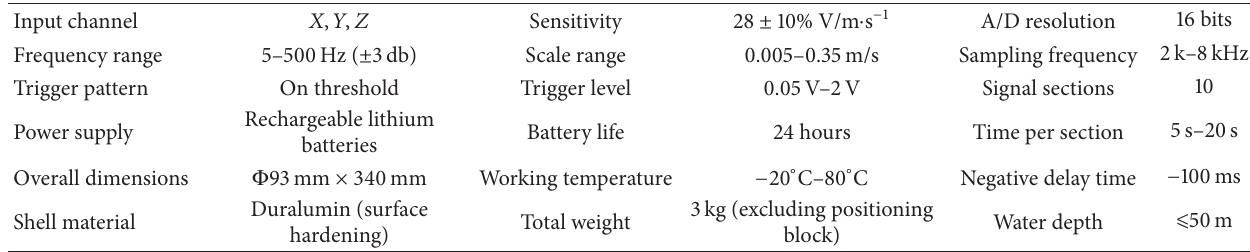
Table 1: Basic performance